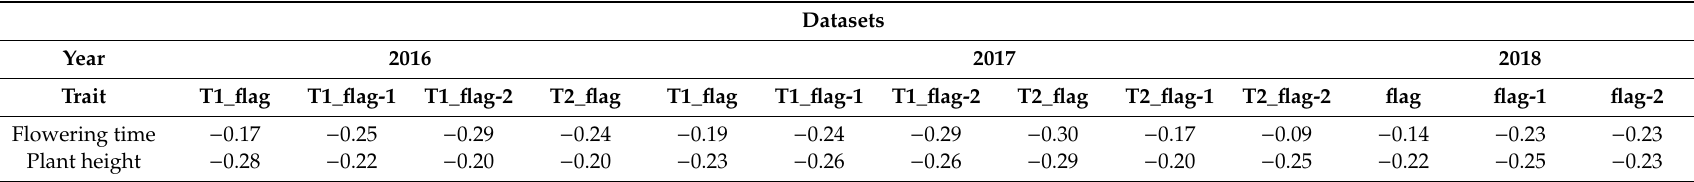
Table 2. Pearson correlation coe ffi cients (r) between septoria tritici blotch (STB) and plant height and flowering time in the MAGIC population in field conditions under natural STB infection.